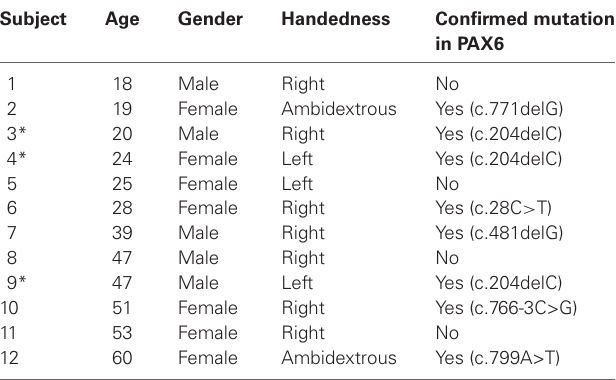
Table 1 | Demographic information on all 12 participants with aniridia